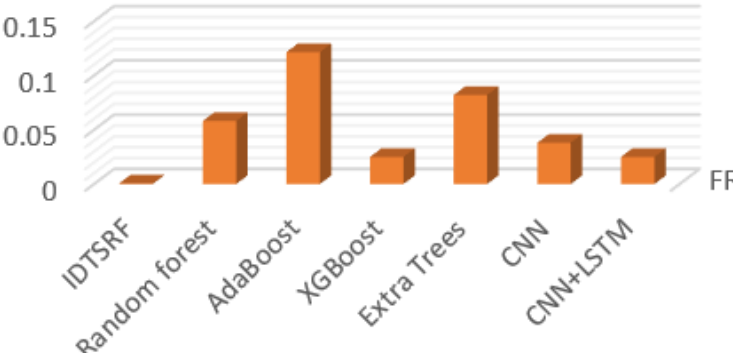
Figure 12. FR Comparison chart.